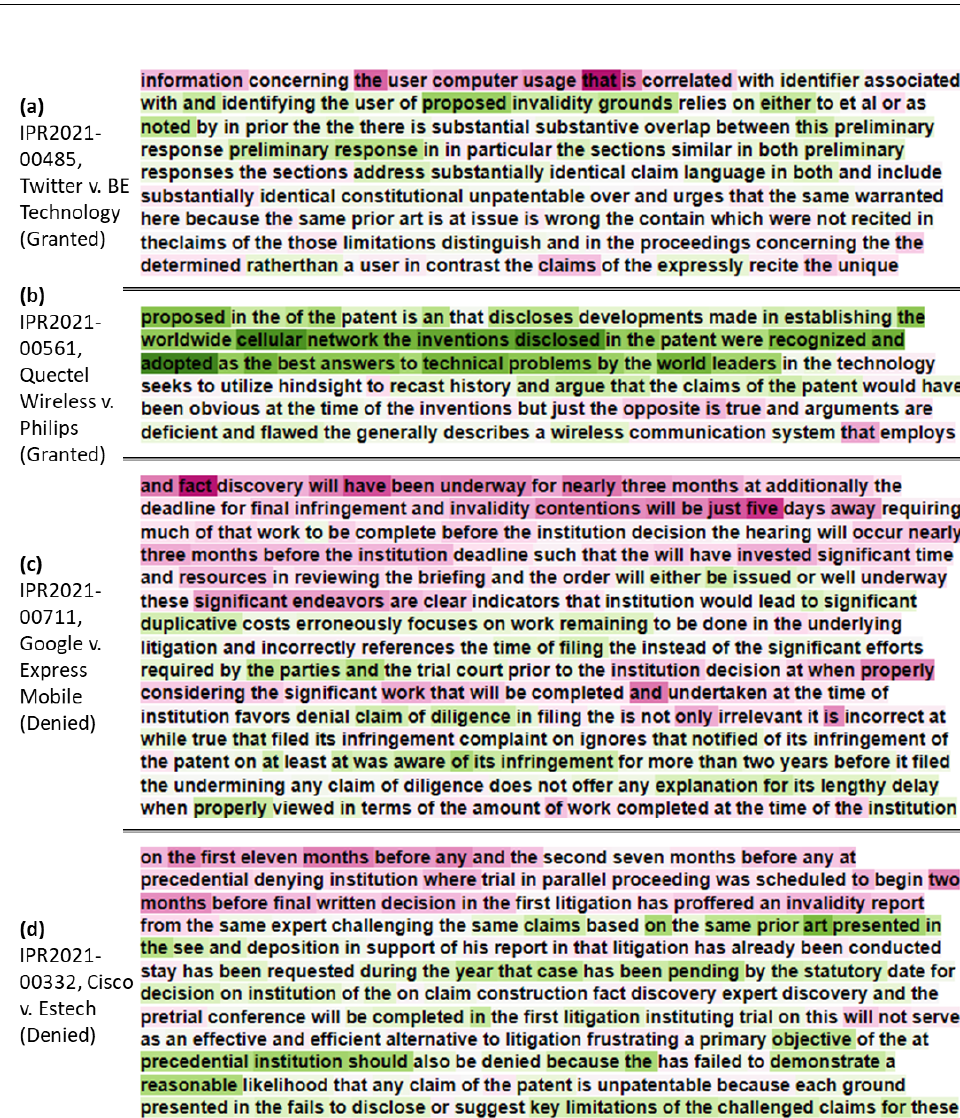
Figure 9. Excerpts of response brief predictions highlighting attention for a kernel size of 8. Green- labeled words are locations where the attention vectors have values greater the median for the sample (excluding the attention at zero tokens where the text was padded), with more intense green corre- sponding to higher levels of attention. Pink-labeled words are locations where attention is below the sample of the median, and more intense pink corresponds to lower attention at that location in the text. The excerpts are labeled with the case (proceeding) number and whether the result was grant or